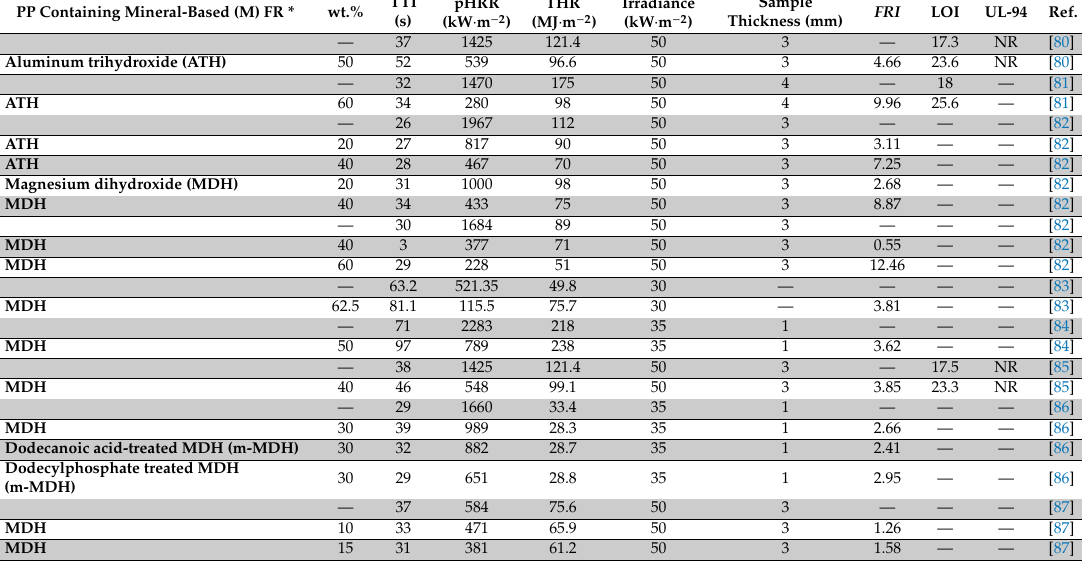
Table 3. Flame-retardant PP materials containing mineral-based (M) flame retardants. Data are extracted from the literature: cone calorimetry parameters (TTI, pHRR, THR), LOI, and UL-94 values. The FRI values were calculated by authors of the present review. The name and the percentage of flame retardants are provided in separate columns. “wt.%” was used for loading level of additives, while “—” stands for the systems free of additive or the neat PP. * FR means flame retardant. Since all comparisons were made in terms of FRI , classification of polymers in terms of their flame-retardant properties was not surveyed based on the chemistry of additives, heat flux, sample thickness, etc. PP Containing Mineral-Based (M) FR *